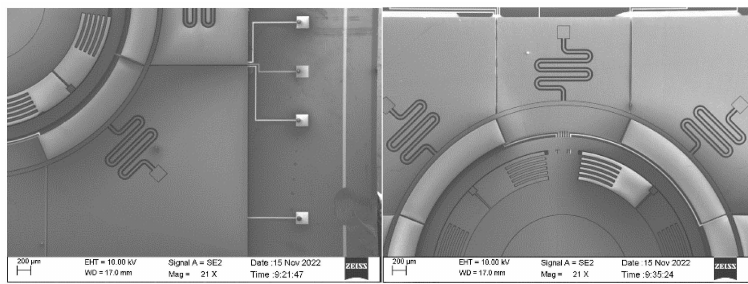
Figure 18. Image of TAG under the